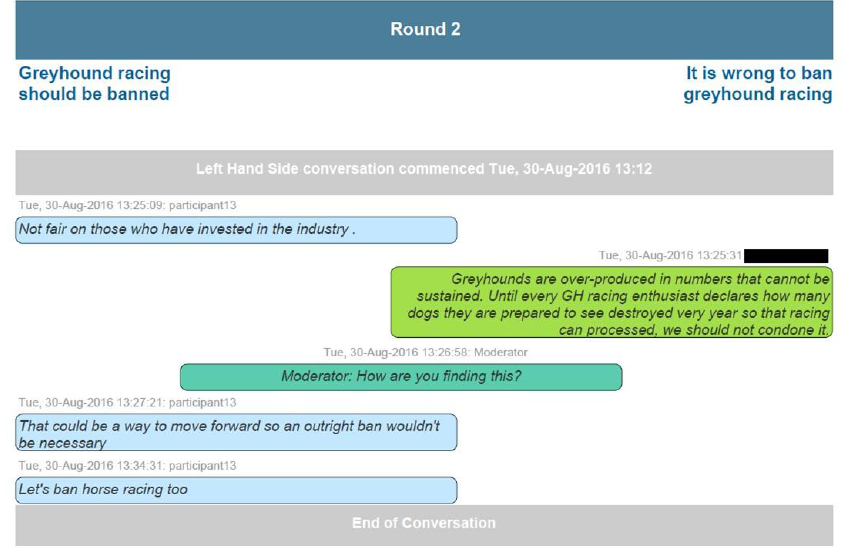
Figure 2. A screen grab from an introductory video to Chatterbox™, available on the One Welfare portal: http://onewelfare.cve.edu.au/chatterbox.